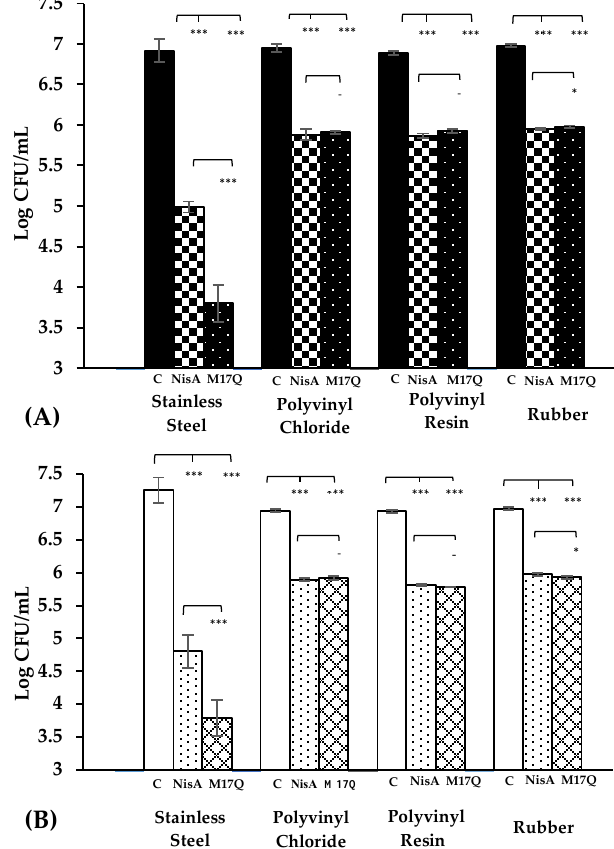
Figure 5. Colony forming units recovered from ( A ) S. epidermidis 28 and ( B ) S. epidermidis 53 on stainless-steel and catheter materials in the absence of nisin